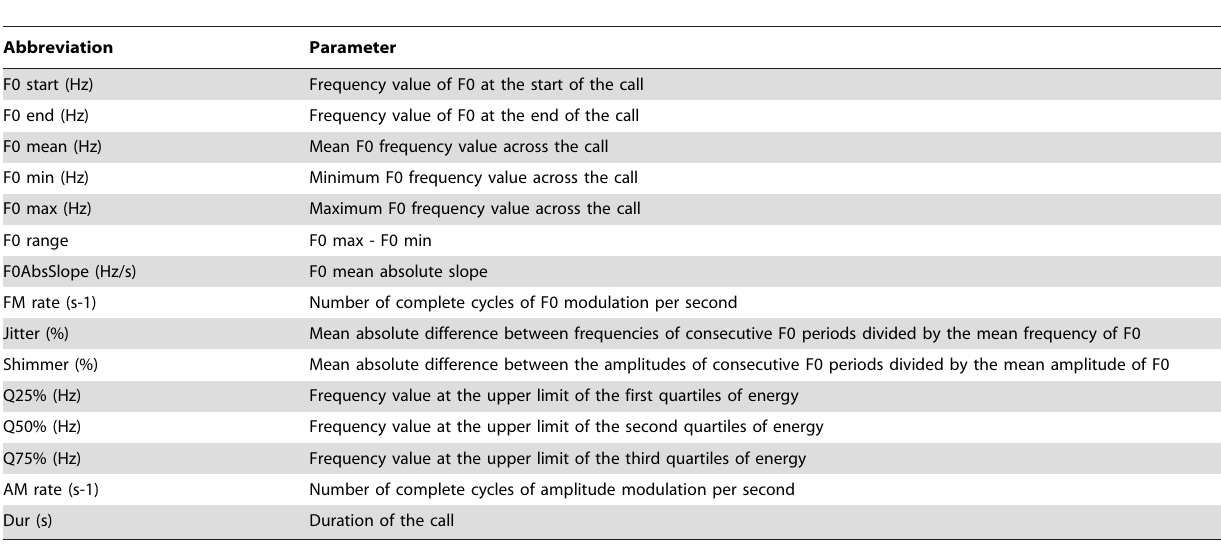
Table 1. List and abbreviations of the acoustic parameters measured on each